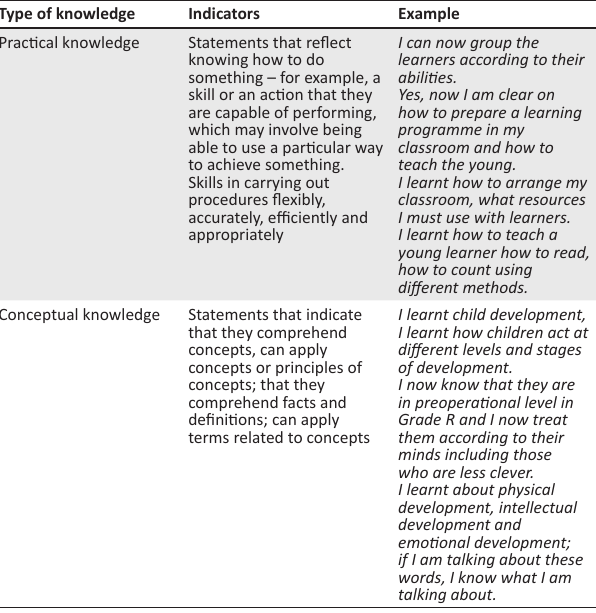
TABLE 2: Types of knowledge, indicators and examples. Type of knowledge